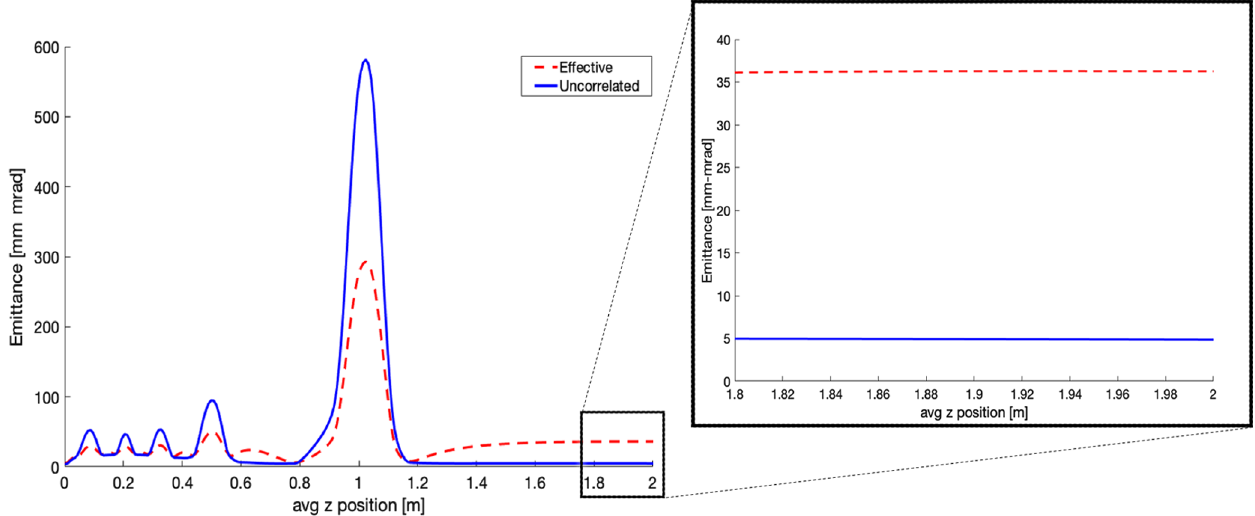
FIG. 8. The evolution of effective rms emittance (red dashed) and uncorrelated rms emittance (blue) from cathode to 1D